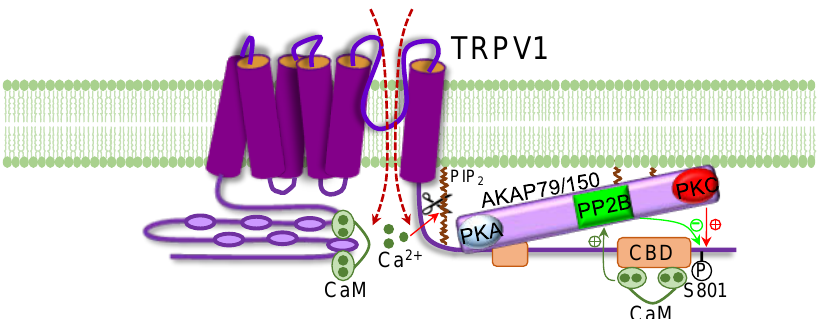
Figure 2. Schematic diagram depicting Ca 2+ -dependent modulation of TRPV1 desensitization. Influxed Ca 2+ binds to CaM. Ca 2+ -loaded CaM then binds to the ARD in the N-terminus of TRPV1, displacing the binding of ATP, leading to channel inhibition. Ca 2+ /CaM also binds to the CaM-binding domain (CBD) in the distal C-terminus and activates PP2B anchored on AKAP79/150 that binds to the proximal C-terminus of TRPV1. Activated PP2B removes and antagonizes phosphorylation of TRPV1 (S801) by PKC and PKA that are also anchored on AKAP79/150. Meanwhile, Ca 2+ induces hydrolysis of PIP 2 , further promoting channel desensitization.